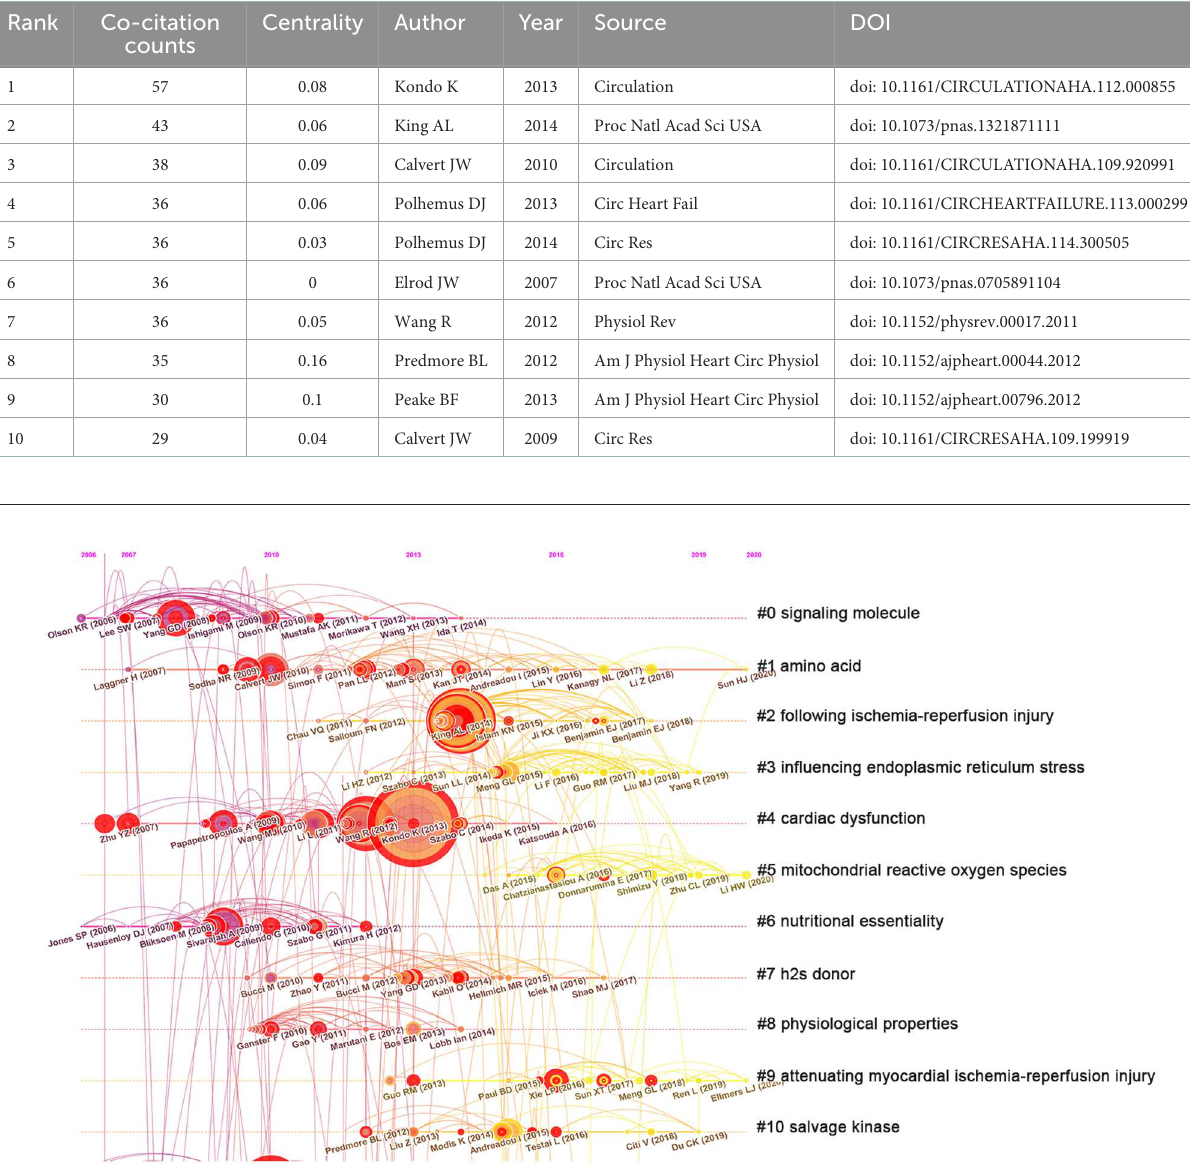
TABLE 4 Top 10 co-cited references in hydrogen sulfide in heart preservation research.